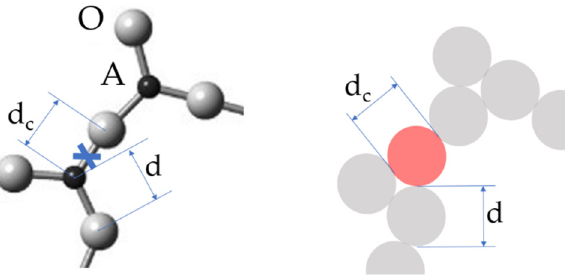
Figure 2. Schematic of a configuron (shown in light red) in the A 2 O 3 glass. The configuron diameter d c is not necessarily equal to the initial bond length d.